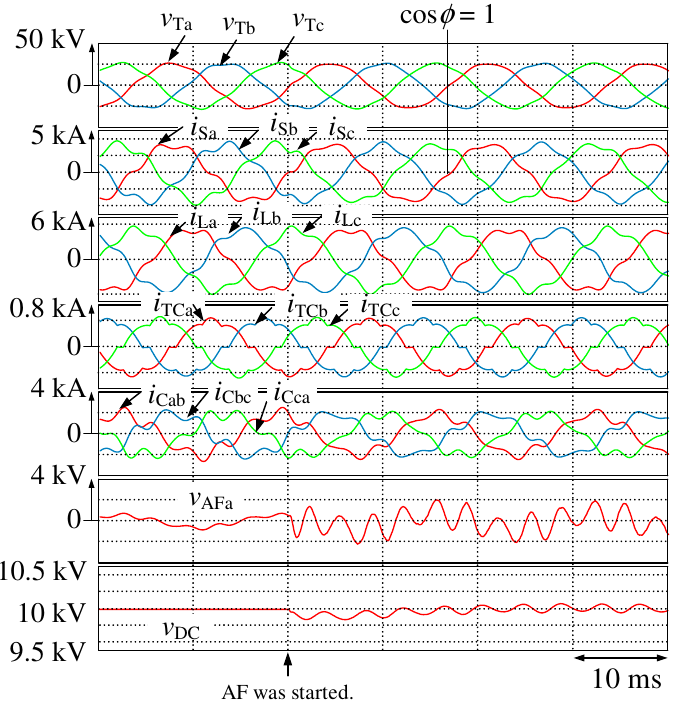
Figure 7. Simulation waveforms for Figure 4 before/after the series active filter (AF) with K C of 10 Ω was started.